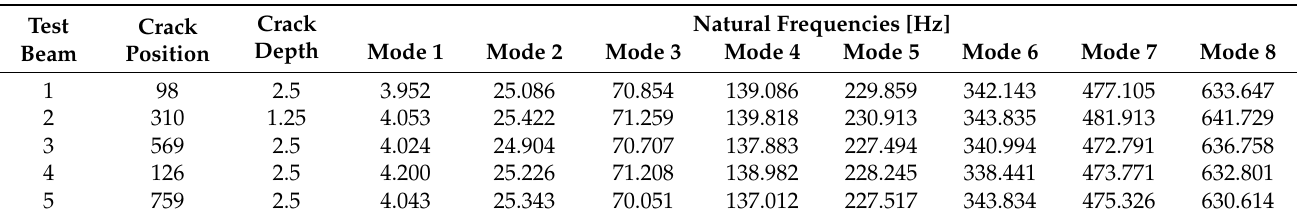
Table 10. Estimated natural frequencies for the test beams containing a crack of known position and